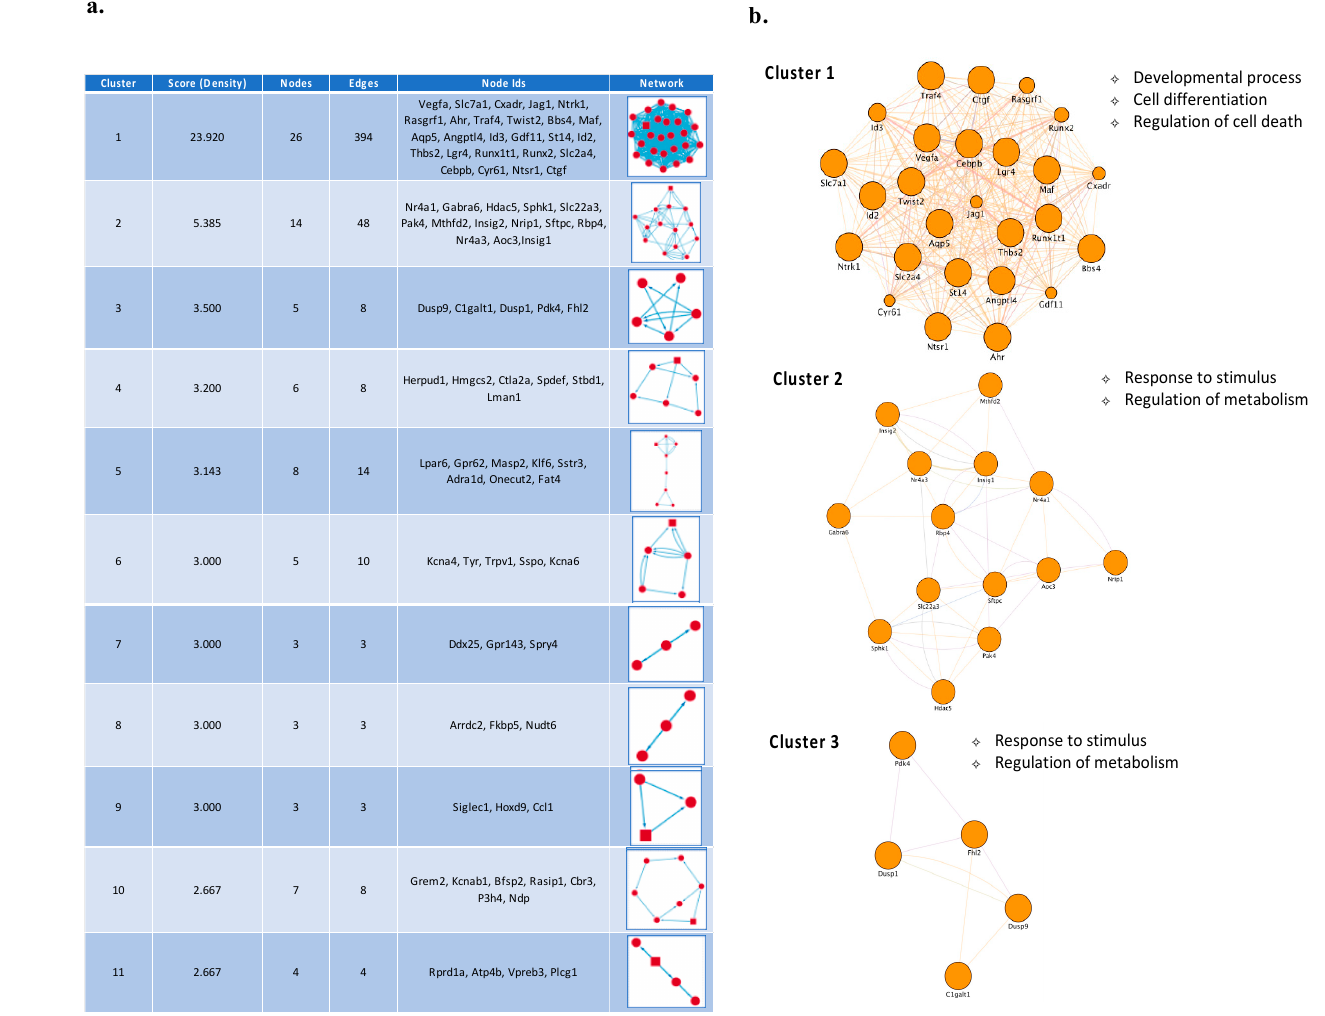
Figure 5. PPI network cluster analysis. ( a ) Sub-network analysis in the PPI network using MCODE identified 11 significant modules/clusters Cluster analysis in the PPI network resulted in 7 clusters, which include 72 nodes and 276 edges, and are enriched for several biological process GO terms. ( b ) Cluster 1, Cluster 2 and Cluster 3 of the top three network clusters in the sub-network analysis of PPI networks of core set genes. These clusters had the highest scores among the clusters. The cluster networks were visualized by Cytoscape by mapping the “degree parameter” to node size.